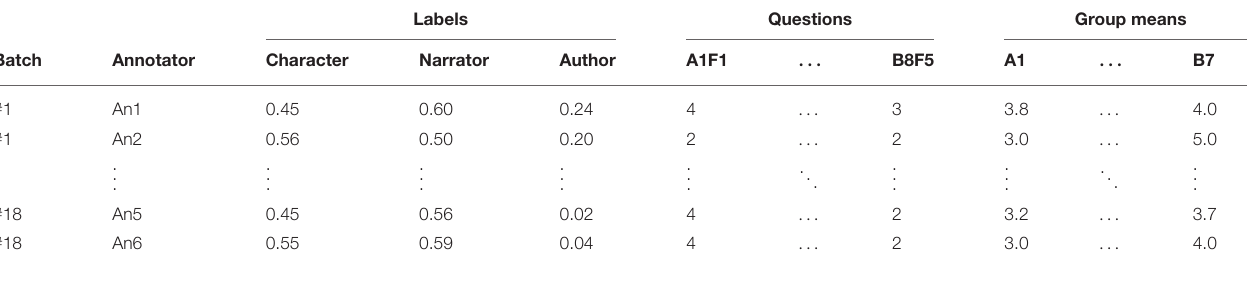
TABLE 4 | Excerpt from the data for the correlation experiment: Label distributions of a specific annotator in a specific batch, and questionnaire answers of the corresponding annotator.